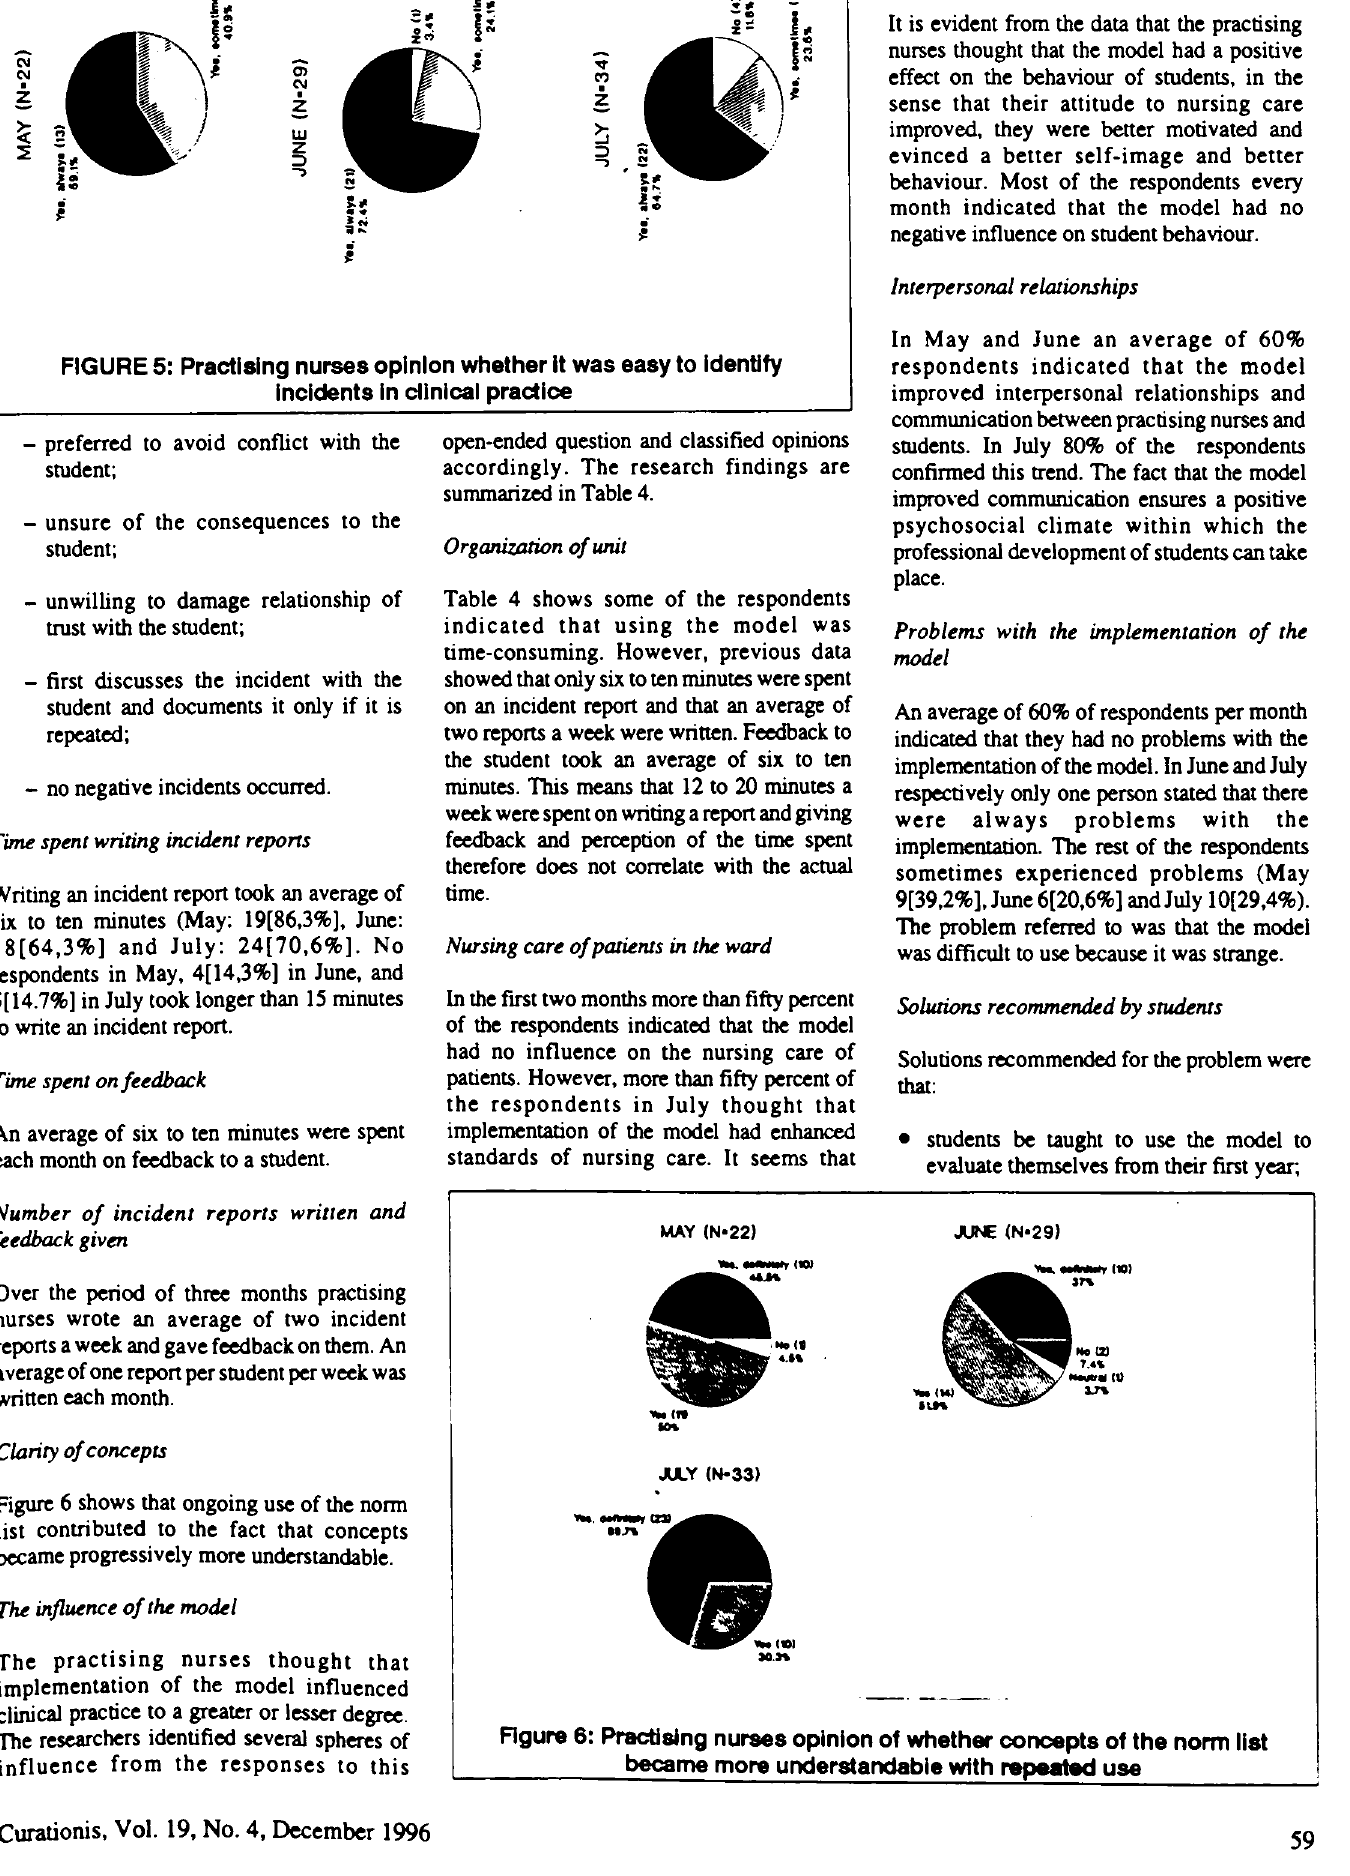
Rgure 6: Practising nurses opinion of whether concepts of the norm iist __________ became more understandabie with repeated